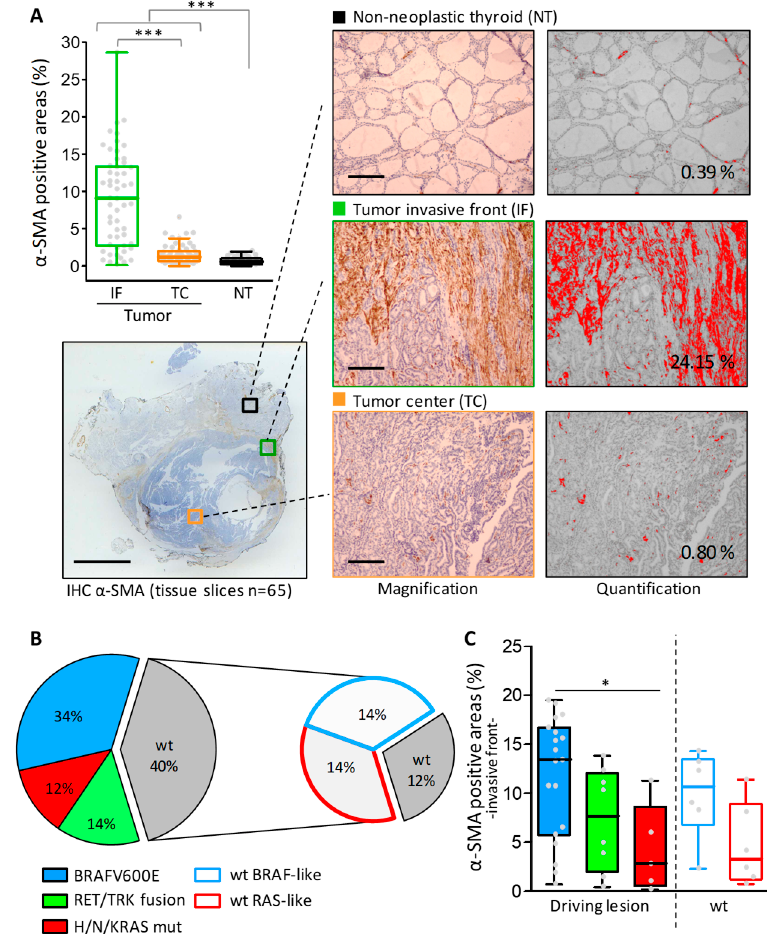
Figure 1. Cancer-associated fibroblasts (CAFs) assessment by α -SMA immunohistochemical staining in human thyroid cancers. ( A ) A boxplot with a scatterplot showing IHC results expressed as α -SMA positive areas calculated by image digital quantification on the stained tissues section from non-neoplastic thyroids (NT) and thyroid tumors (scored separately for invasive front (IF) and tumor center (TC)). Each dot represents the mean of 2–3 fields scored for each sample. Below an example of α -SMA stained tissue section (scale bar: 5 mm) with representative scored regions (high magnification, scale bar: 500 µ m) and the corresponding ImageJ threshold mask with the measured positive area (expressed as a percentage). ( B ) Tumor genotyping results. Pie charts represent the distribution of identified driving lesions or BRAF- / RAS-like signaling in tumor tissues; wt: samples with no alterations in the tested lesions. ( C ) Boxplot with scatterplot showing α -SMA IHC results in tumor samples stratified for genetic driving lesion or BRAF- / RAS-like signaling. *** p -value < 0.0001 and * p -value < 0.05 by Mann-Whitney test.